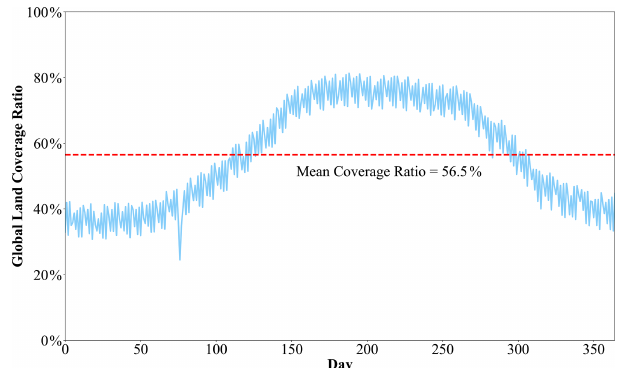
Figure 2. The daily global land coverage ratio of AMSR2 soil moisture products in